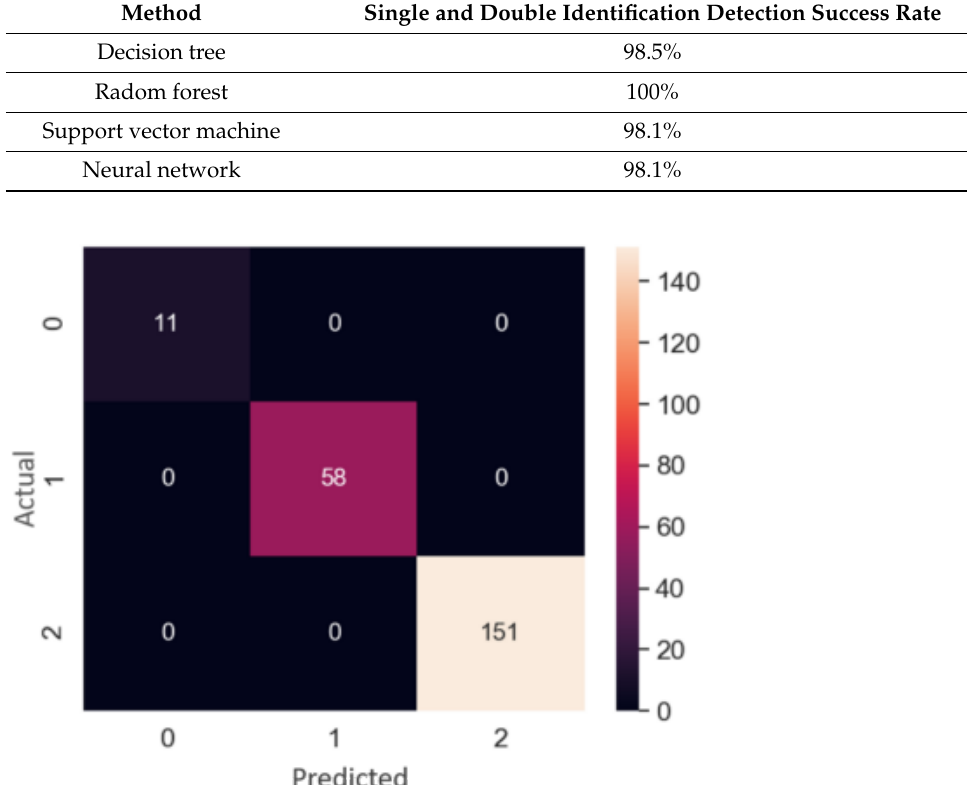
Figure 17. The confusion matrix of the classification results of random forest single and double identification. Table 11. Comparison of single and double identification and classification methods.